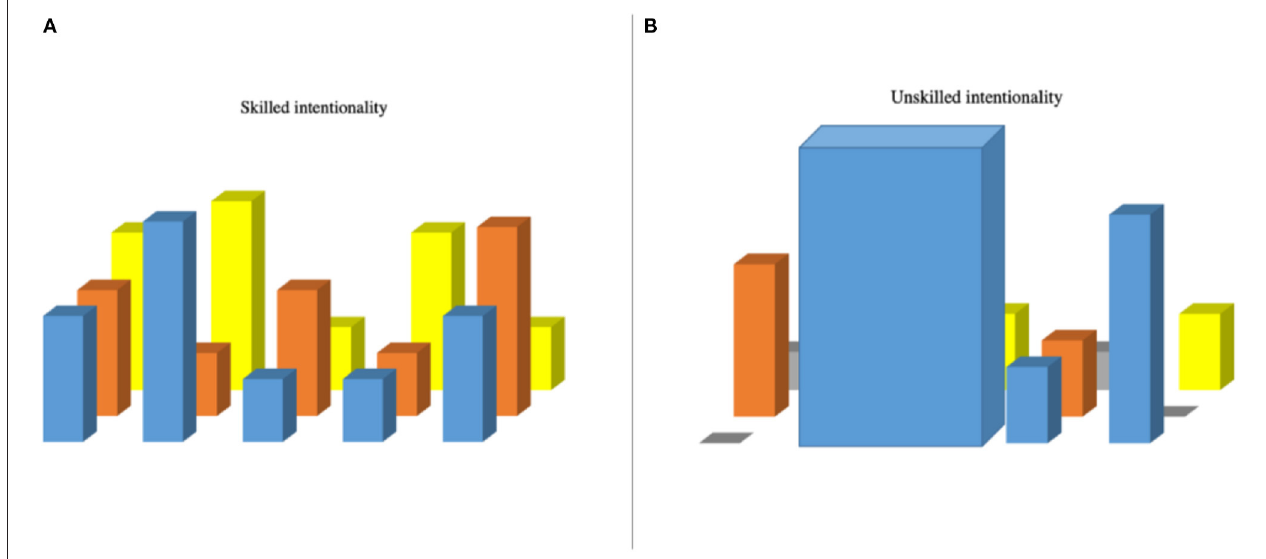
FIGURE 6 | A field of relevant affordance shaped by skilled (A) and unskilled (B) intentionality. Figure illustrates (A) an athlete’s responsiveness to a field of affordances indicative of skilled intentionality; and (B) illustrates a field of affordances indicative of unskilled intentionality, whereby an overbearing value-directedness leads some more soliciting affordances to “stand out,” while others become overshadowed, and more still are imperceptible